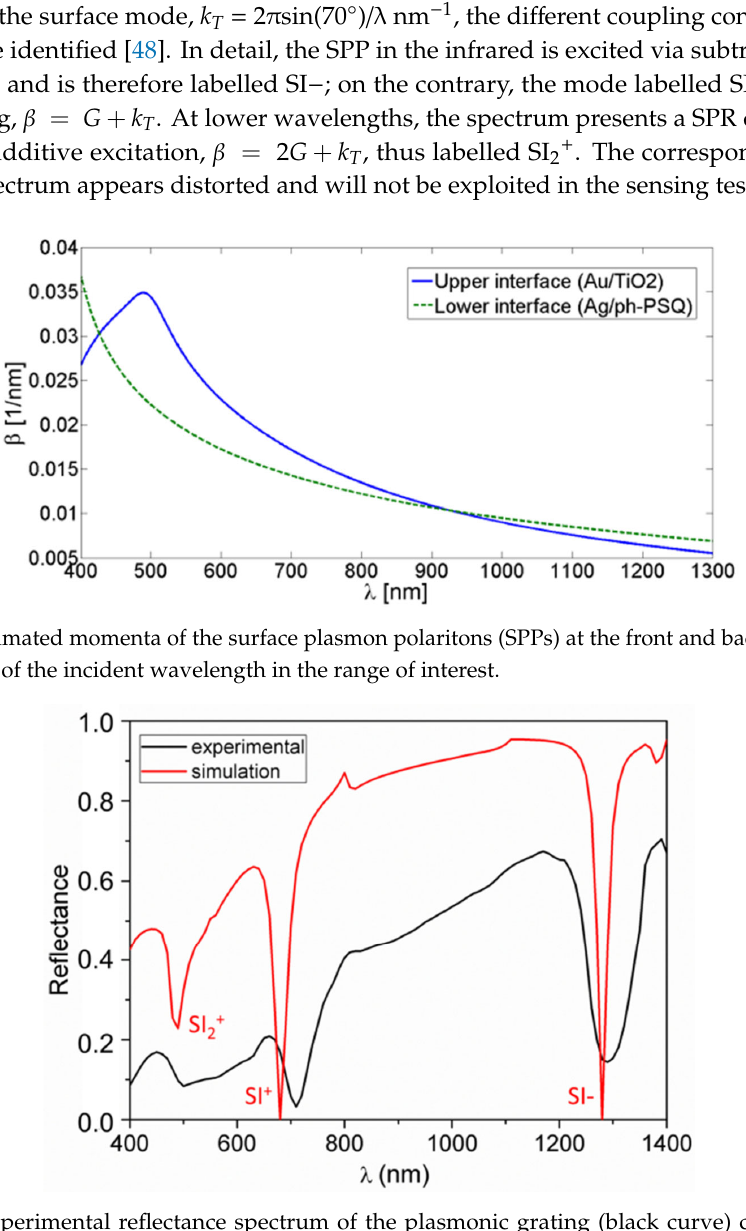
Figure 4. Experimental reflectance spectrum of the plasmonic grating (black curve) compared to simulation (red curve). The illumination is front-side at a fixed incidence angle of 70 ◦ . The nature of the modes is identified by comparison to their theoretical momenta, as follows: the label SI stands for single-interface mode, with a sign indicating if the coupling is additive or subtractive and a number “2” for a mode coupled through the second di ff raction order.